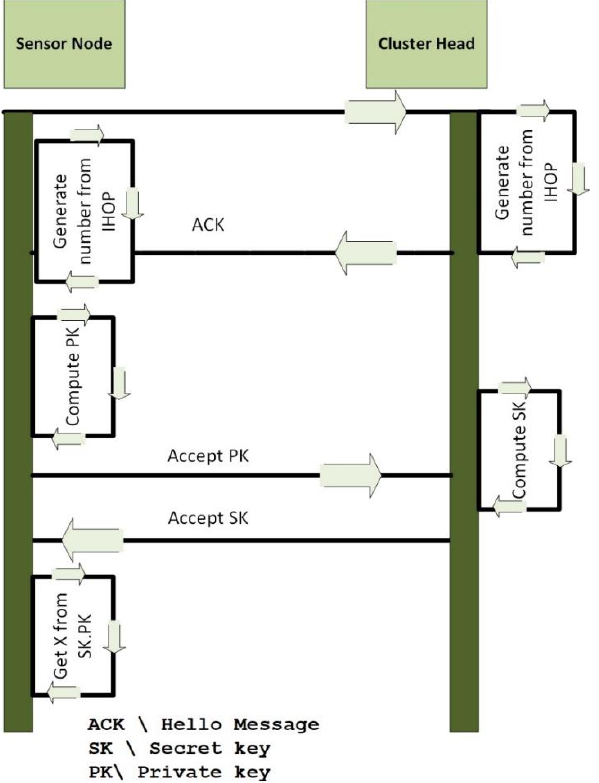
Figure 2. Key sharing using IHOP mechanisms.